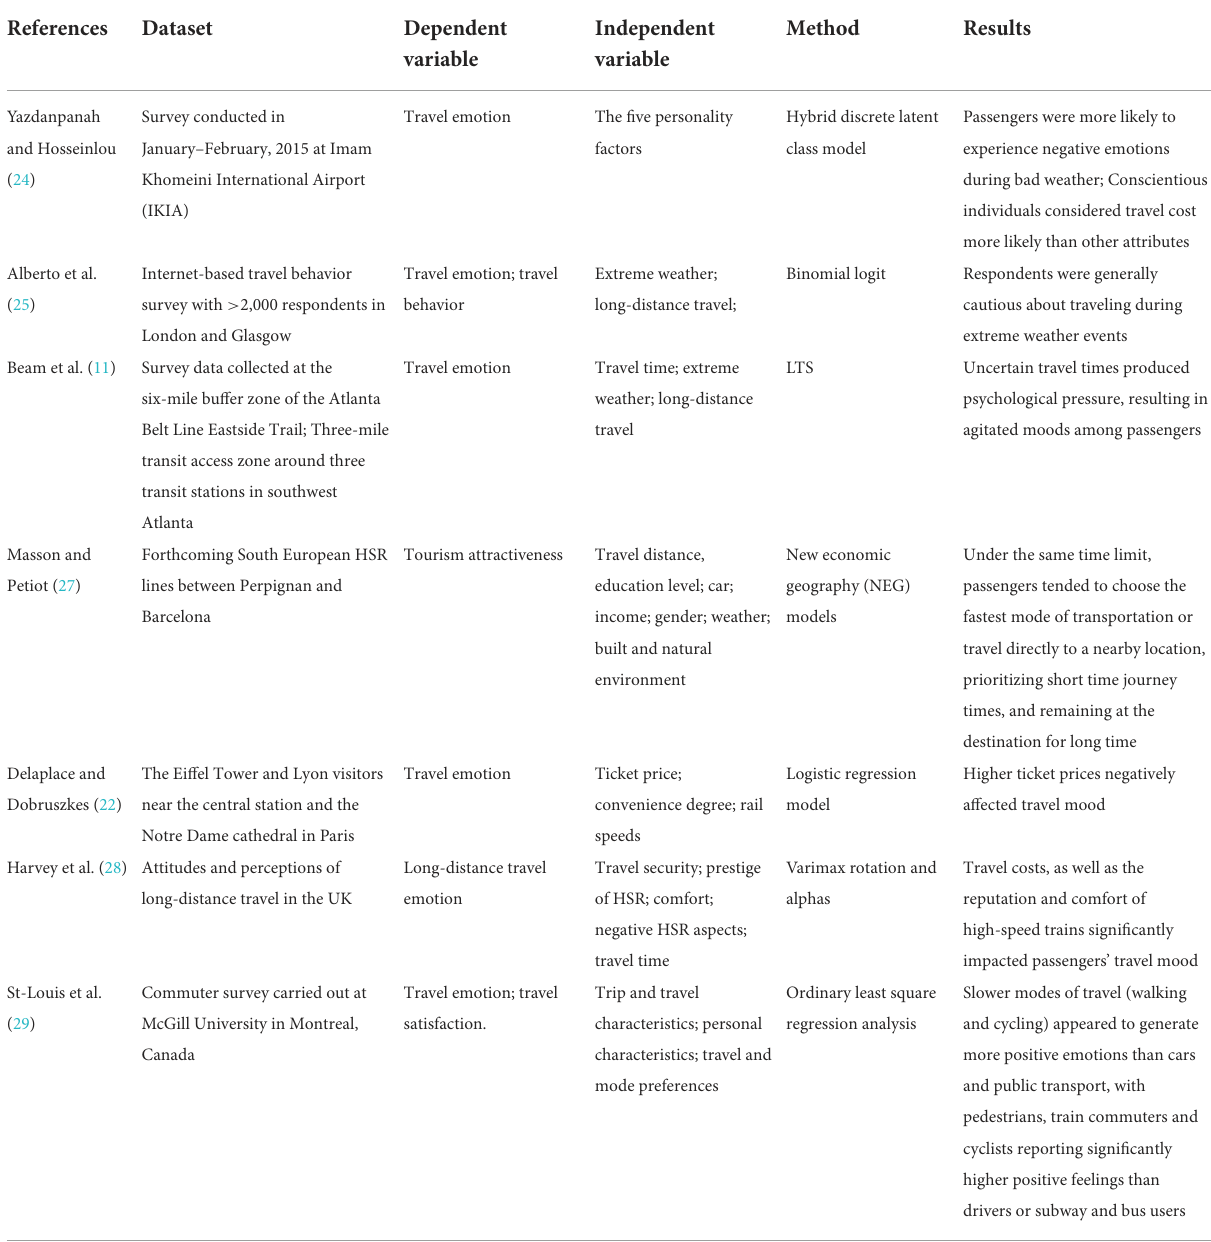
TABLE 1 Previous intercity travel passenger emotion